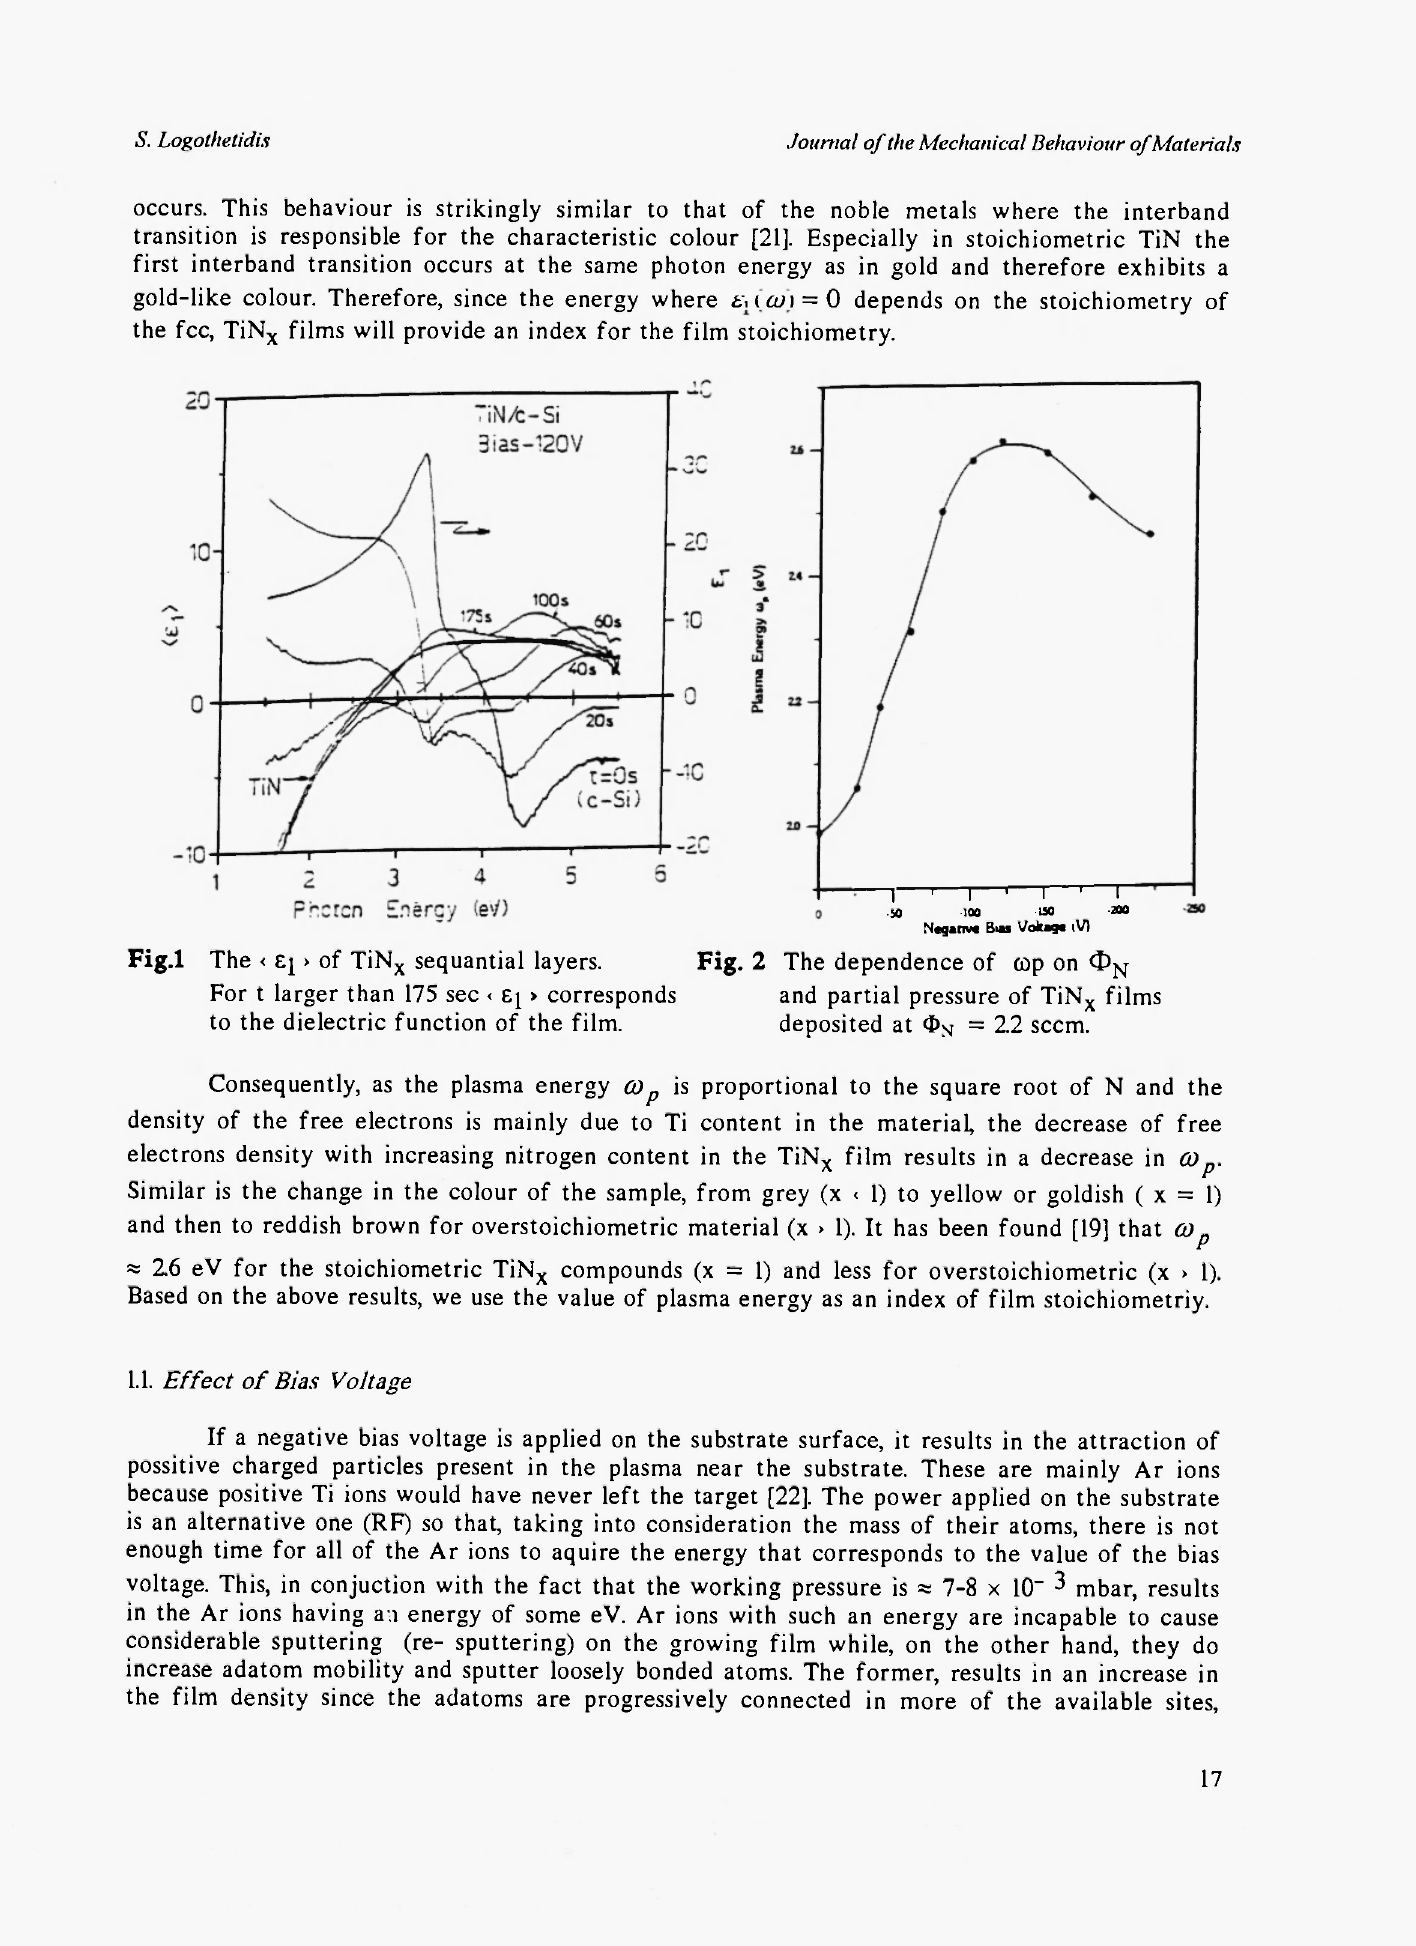
Ν films x = 2.2 Ν